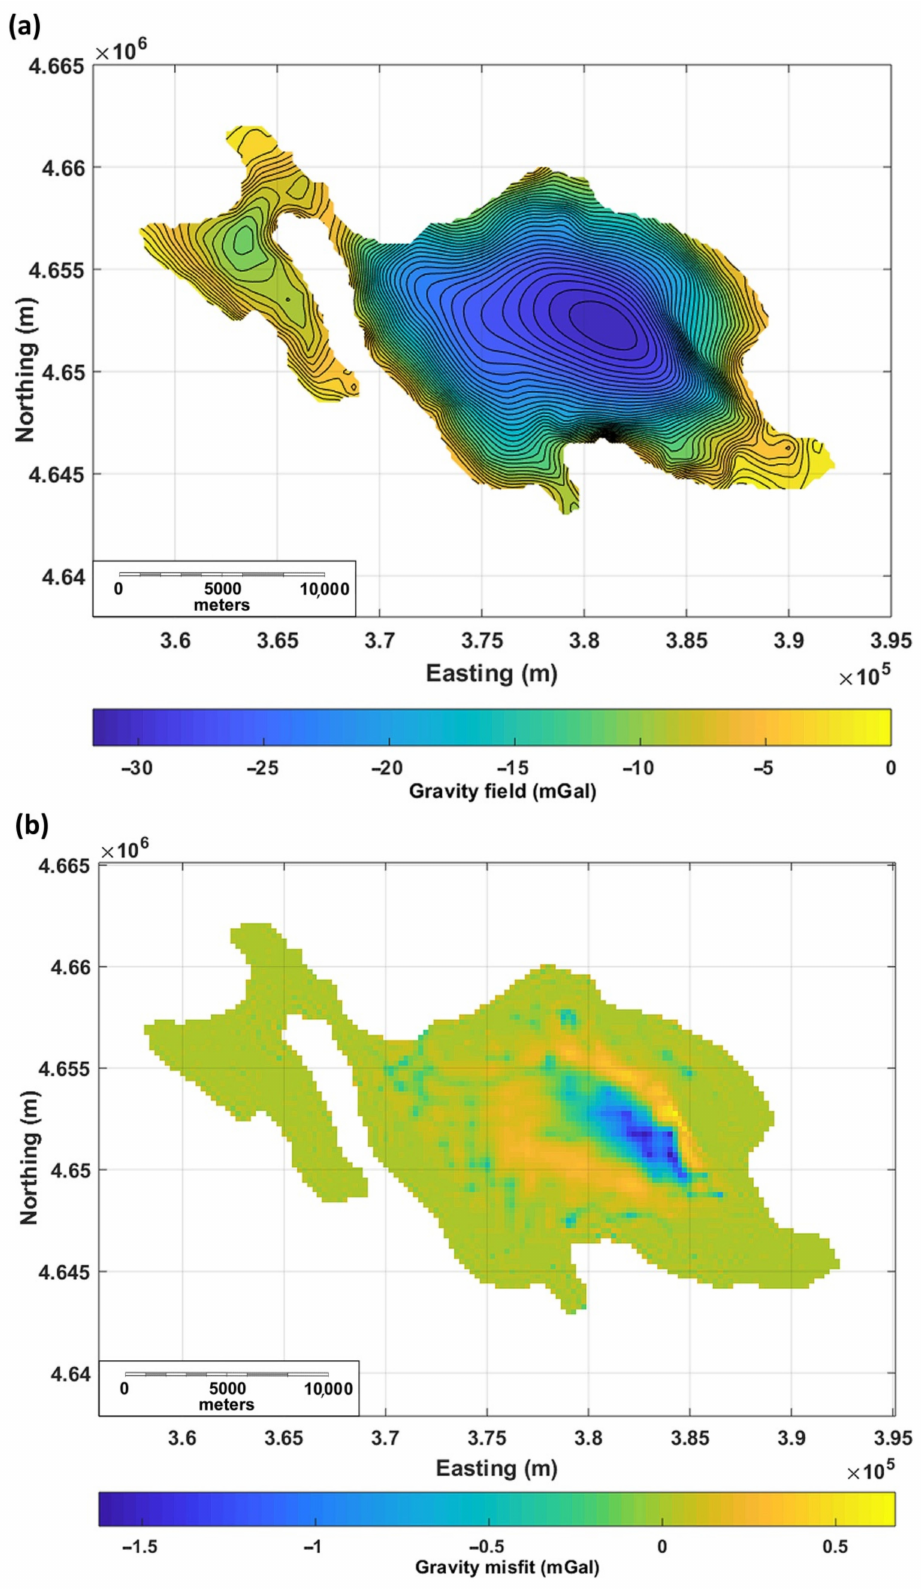
Figure 7. ITRESC basement model. ( a ) Model-predicted gravity field (compared with the residual gravity of Figure 2); contour lines interval: 1 mGal. ( b ) Gravity misfit (difference between residual and predicted